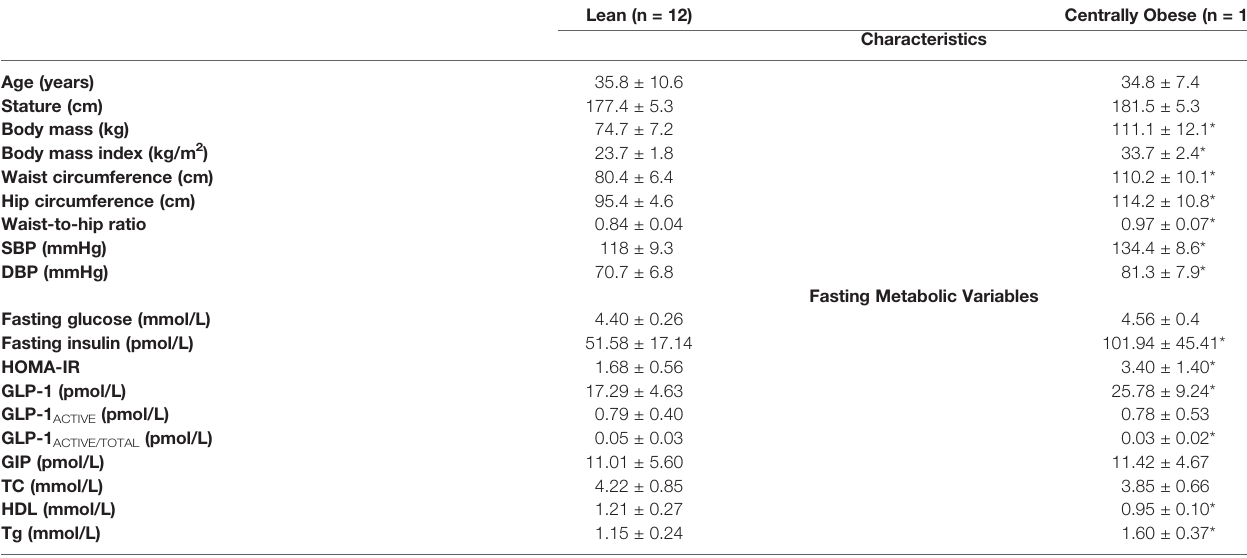
TABLE 1 | Cohort characteristics.